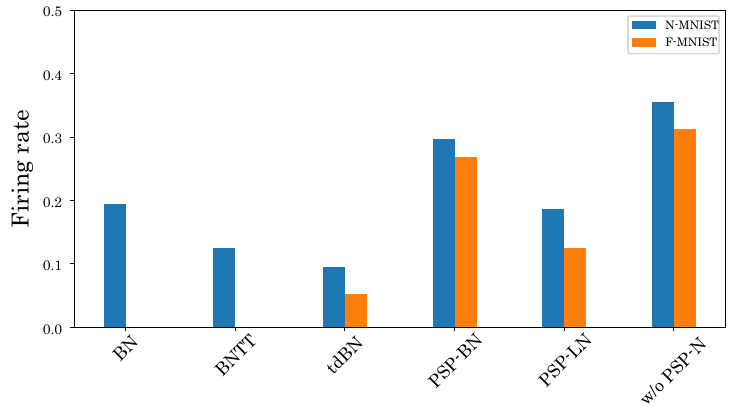
Figure 9. Total firing rates of each